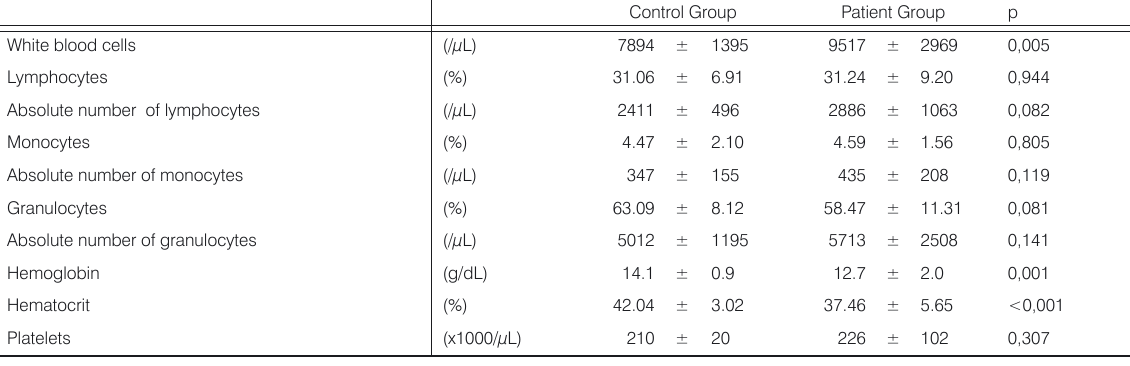
Table 2. Hematologic